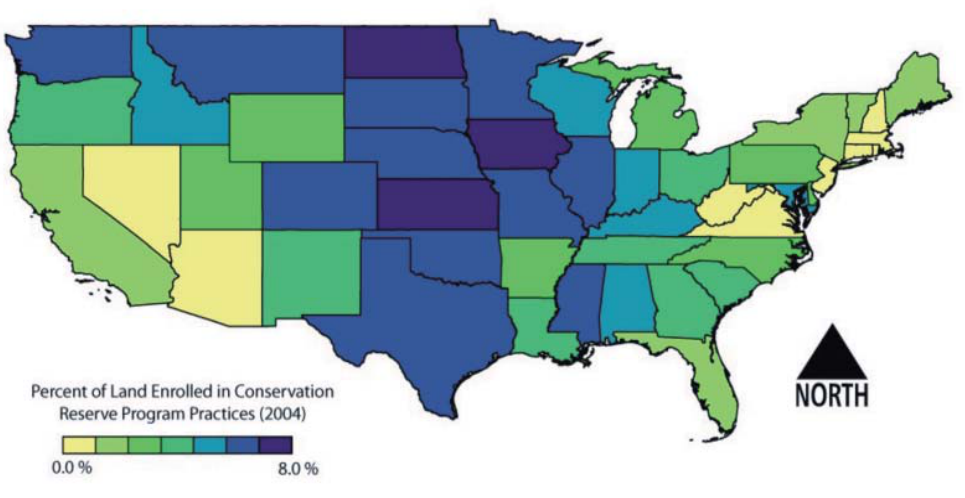
Figure 1. Percent of land enrolled in the Conservation Reserve Program in 2004 (data from USDA Farm Service